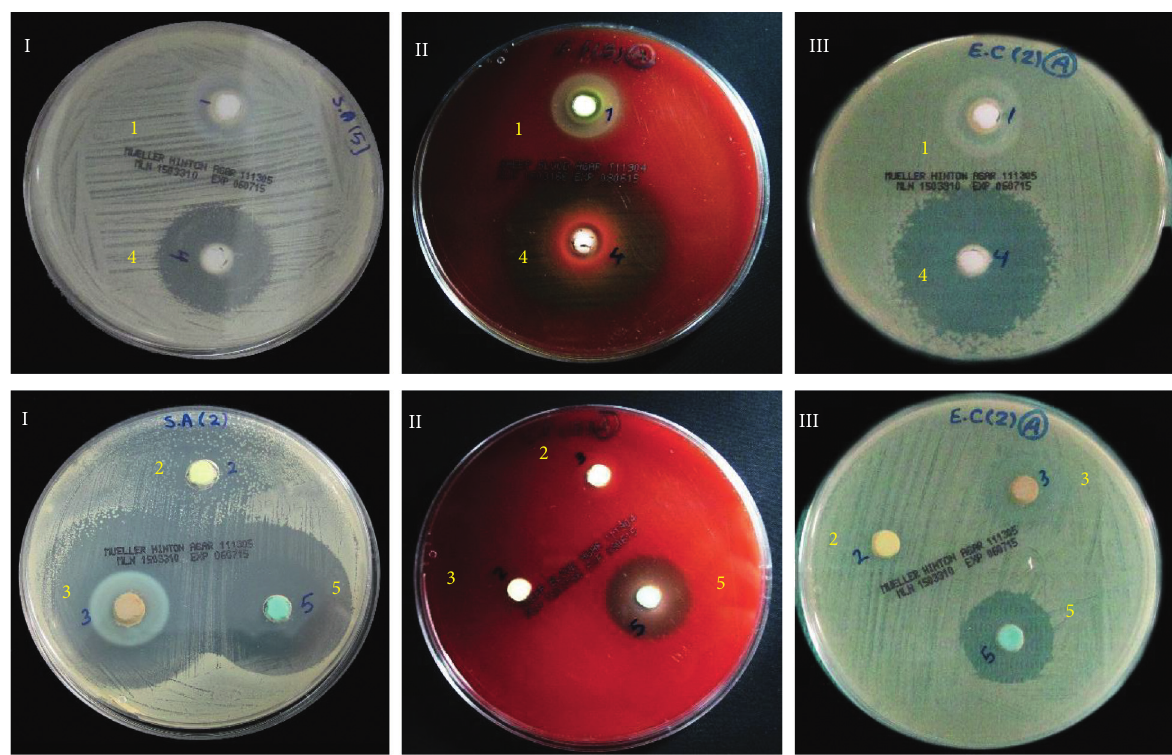
Figure 4: Zones of microbial growth inhibition around each experimental medicament for all tested microbial strains (Medicaments: 1: calcium hydroxide; 2: Diapex Plus; 3: Ledermix; 4: sodium hypochlorite gel; 5: CHX gel; Microbial strains: (I) S. aureus ; (II) E. faecalis ; (III) E. coli